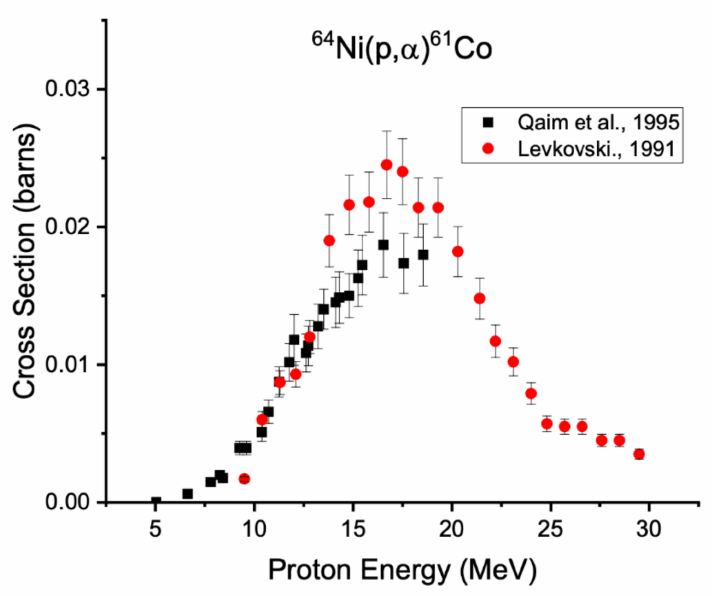
Figure 11. Excitation functions for production of cobalt-61 from nickel-64